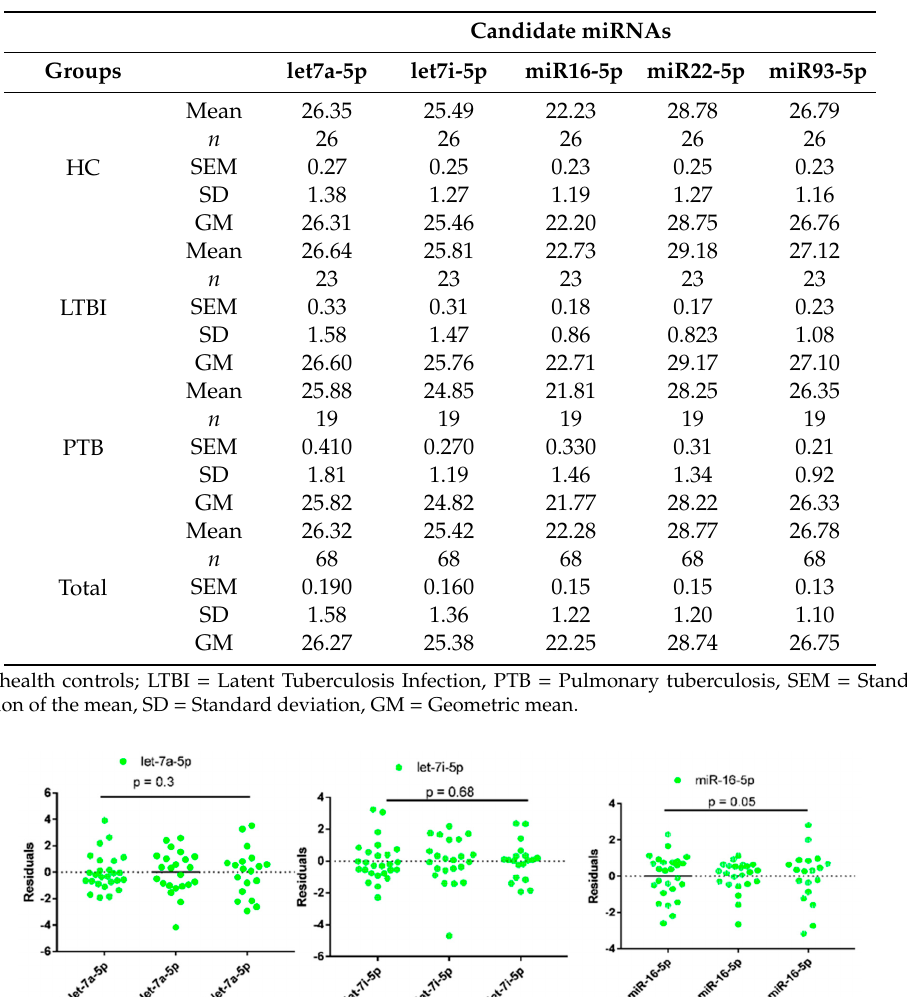
Table 3. Statistical distribution and mean analysis report of miRNAs in study participants.